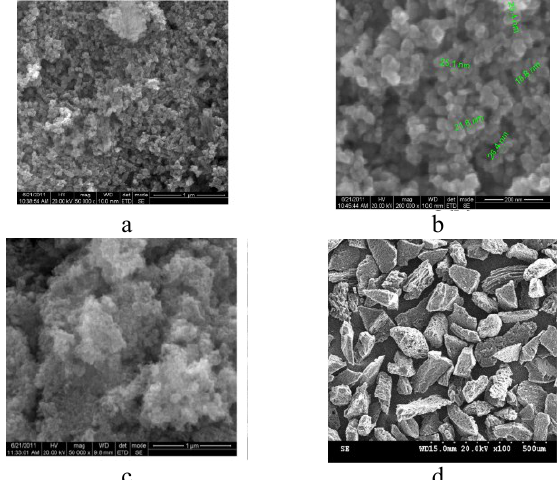
Figure 2. SEM micrograph for 2a) Synthetic nano Fe